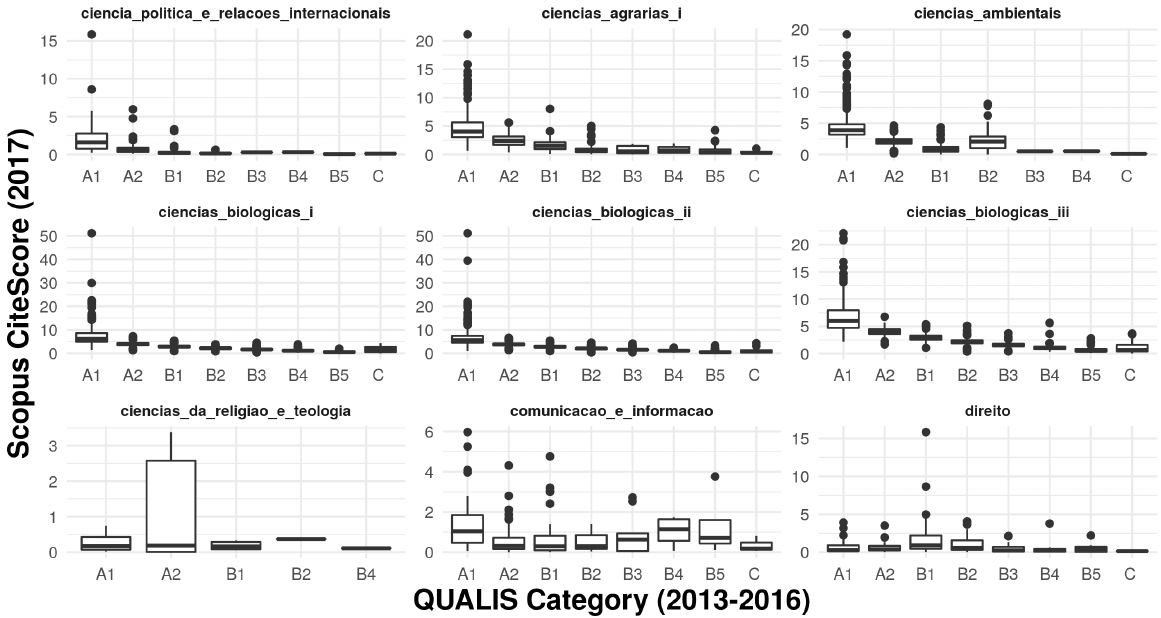
Figure 4. Scopus CiteScore variation across QUALIS categories in nine subject area. Original QUALIS subject area names are shown (as written in their respective classification sheets) but their English translation can be found in Table